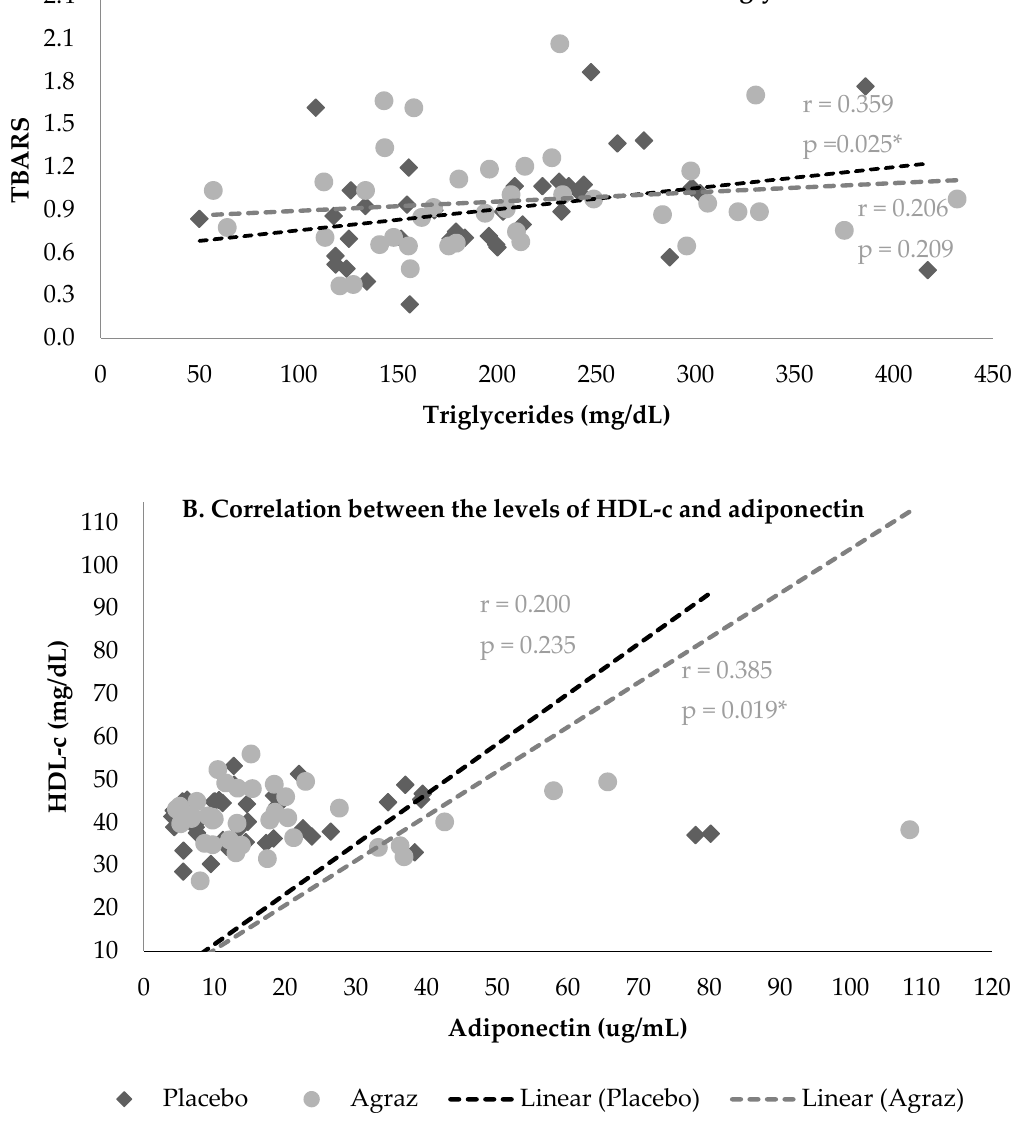
Figure 3. Spearman correlations between the concentrations of Triglycerides and TBARS ( A ) and HDL-c and adiponectin ( B ) after agraz and placebo consumption in women with MetS. * p ≤ 0.05 is considered significant. r: correlation coefficient.